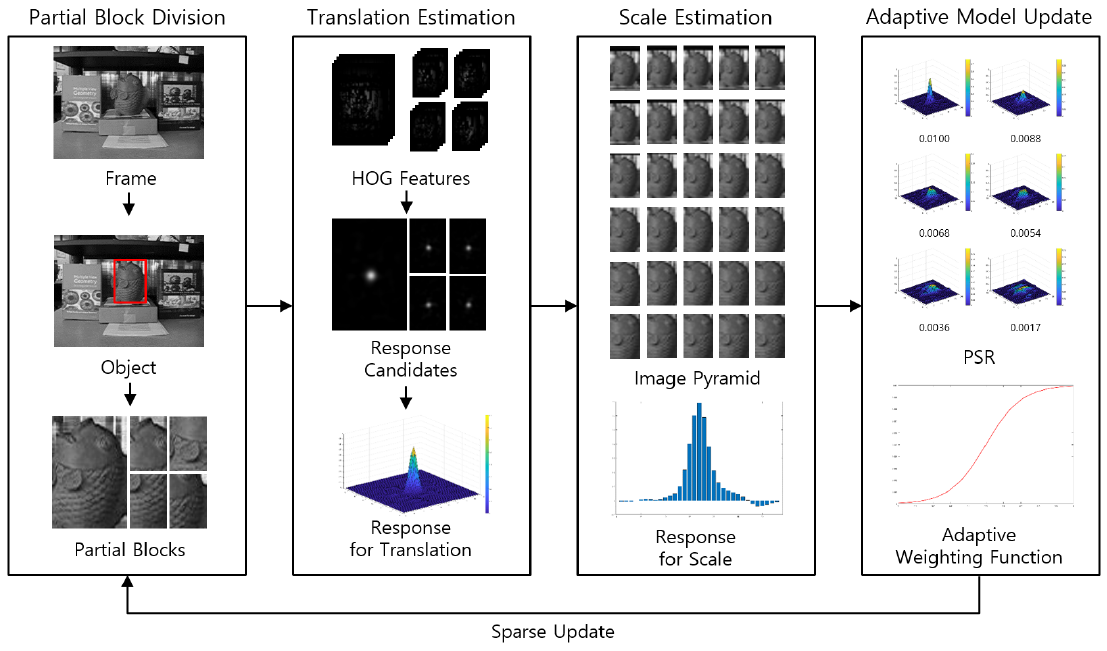
Figure 2. The block diagram of the proposed method. We separate the partial blocks from the object in the frame and perform the translation estimation and scale estimation. Finally, we perform the model update with the weighting function or skip the update. PSR, peak-to-sidelobe